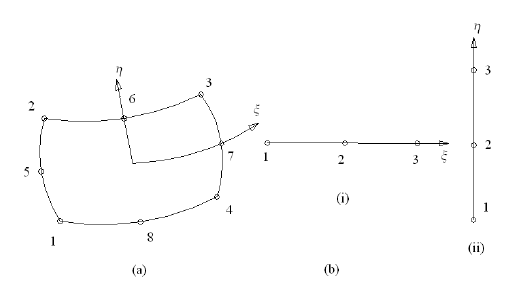
Figure 2: (a) Eight noded shell element with isoparametric co- ordinates (b) Three noded stiffener elements (i) x-stiffener (ii) y-